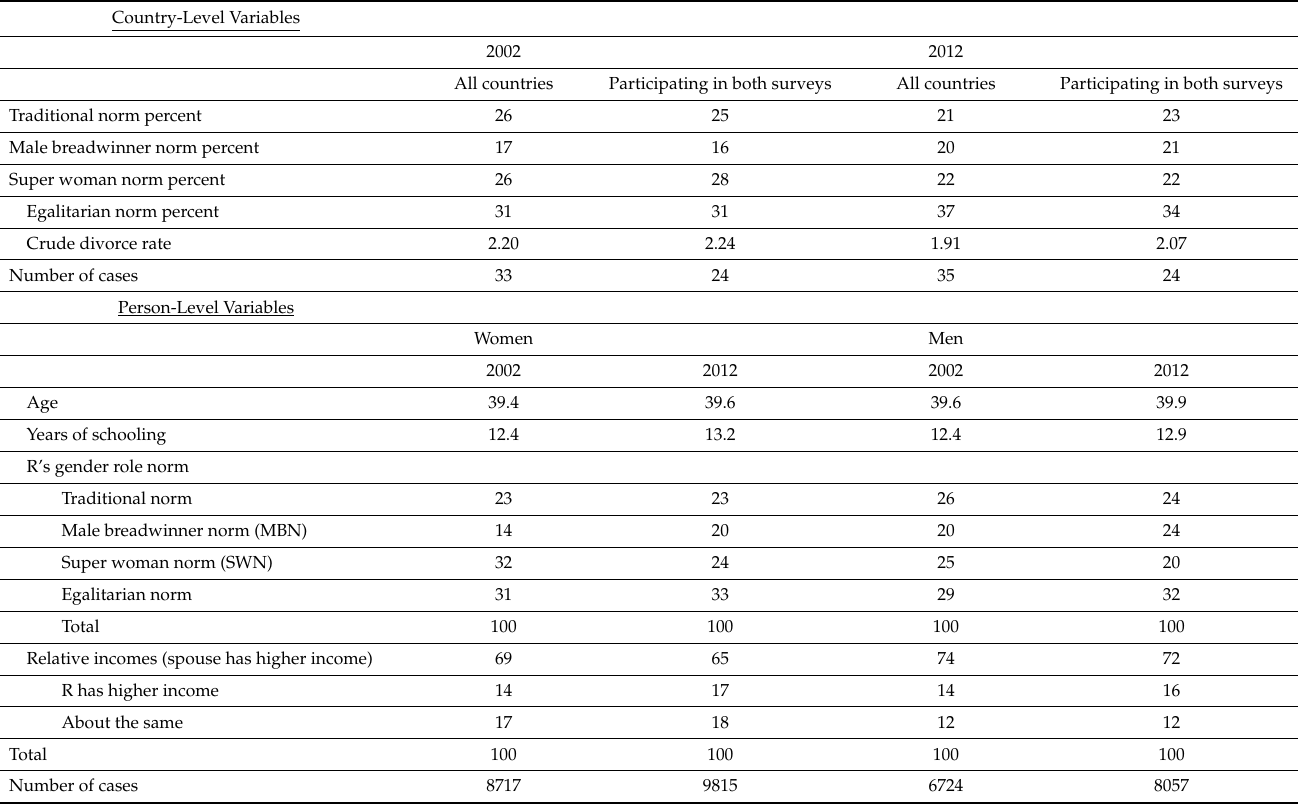
Table 1. Descriptive statistics: mean values and percentage